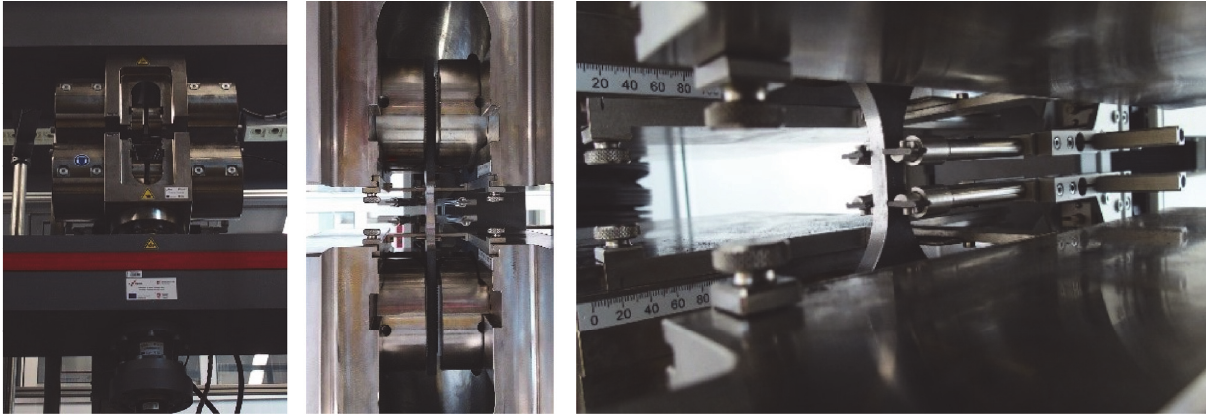
Figure 2: Details of the device.